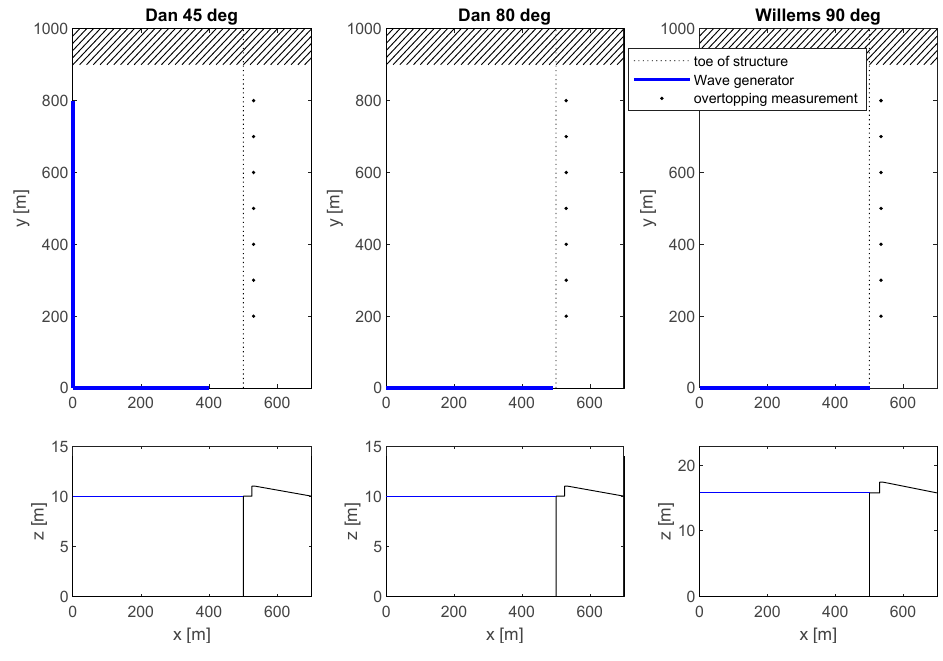
Figure 3. Plan and cross-sectional view of the SWASH domain settings for wave overtopping simulations (3 different wave directions: 45, 80 and 90 degrees).